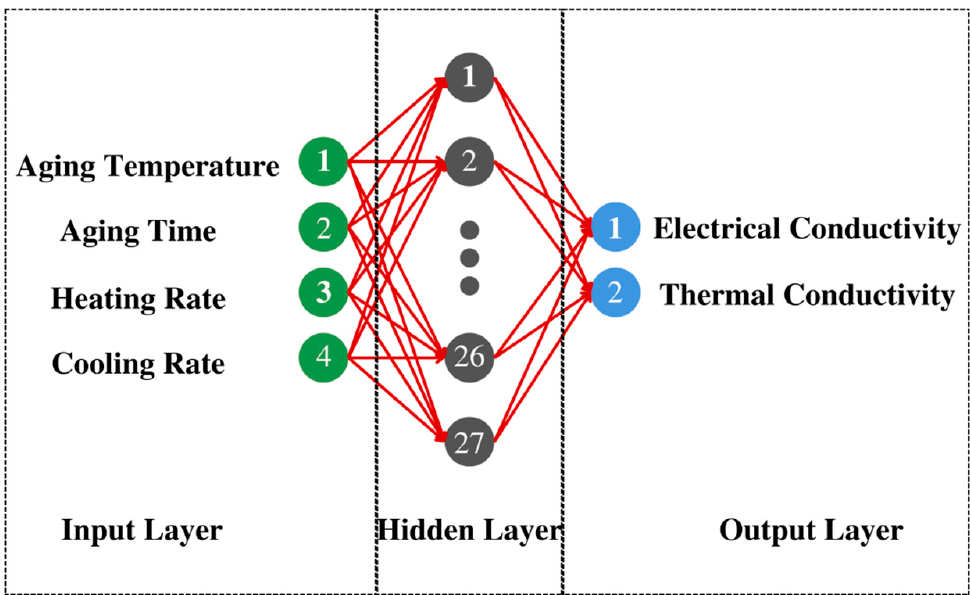
Figure 6. Structure of Back Propagation Artificial Neural Network used in the study.